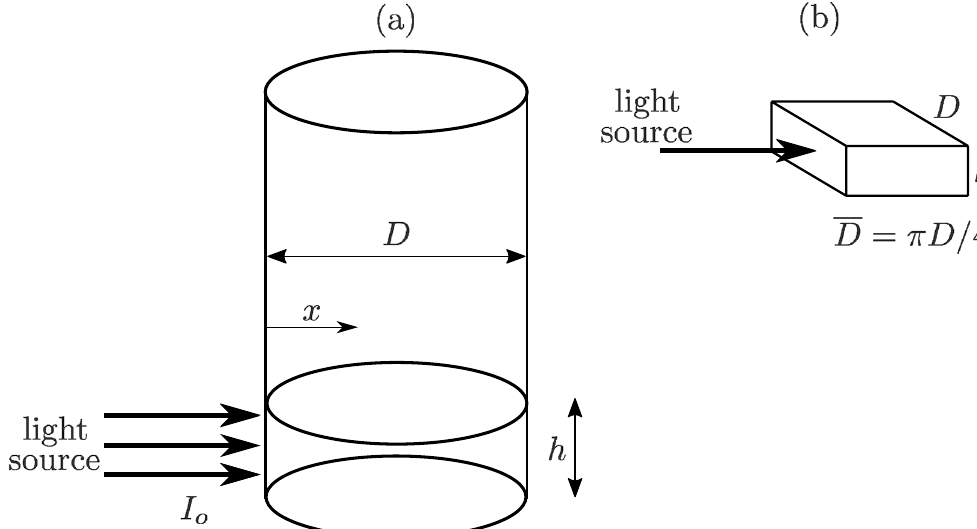
Figure 11. Theoretical analysis of the indoor set-up (the figure was created using Inkscape version